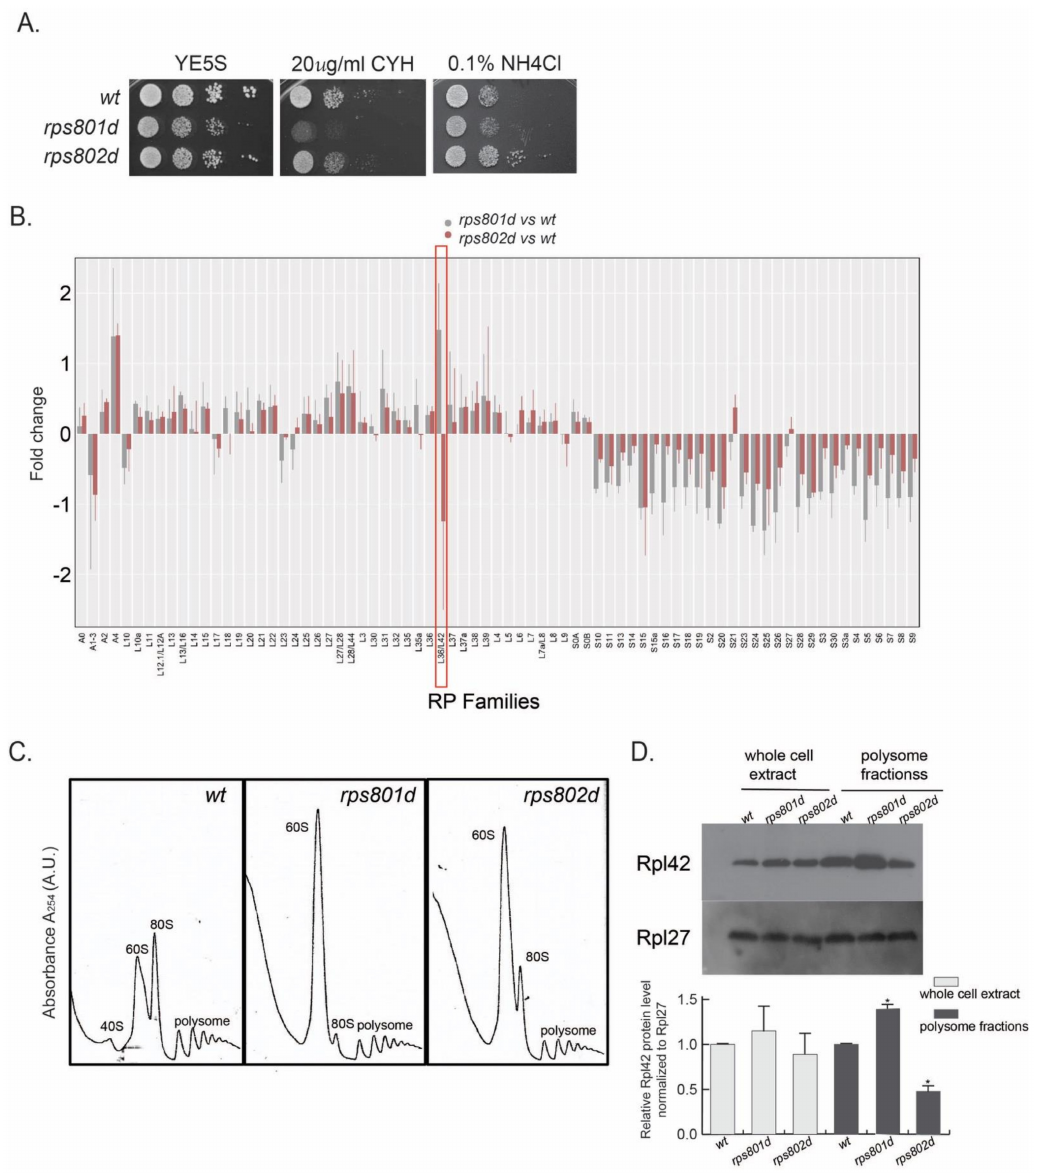
Figure 1. Rps8/eS8 paralog deletions exhibit different phenotypes upon various cellular process. ( A ) rps8 paralog deletions display paralog − specific phenotypes on the translation inhibitor drug (cycloheximide) and amino acid starvation (YE supplied with excess NH 4 Cl). ( B ) Quantification of ribosome proteins in rps8 paralog deletions, as well as wild types, by mass spectrometry. The details are described in Section 2. The fold change of Rpl42/eL42 (Rpl36A) exhibits an outstanding pattern. ( C , D ) Polysome analysis by sucrose gradient − based centrifugation among the wild − type, rps801d, and rps802d and quantification of the Rpl42/eL42 protein by Western blotting. Log − phase yeast grown on a rich medium supplemented with 100 uM cycloheximide prior to harvest in order to stabilize translating the ribosomes. The same amount of total cell extract was applied to sucrose gradient centrifugation. To localize the ribosomal subunits (40S and 60S) and intact ribosomes (80S and polysomes), fractionation was monitored at 254 nm. One − tenth of the total cell extract, as well as the protein extract from the polysome fractions, was immunoblotted. p − values were obtained by two − tailed Fisher’s exact test. * p <